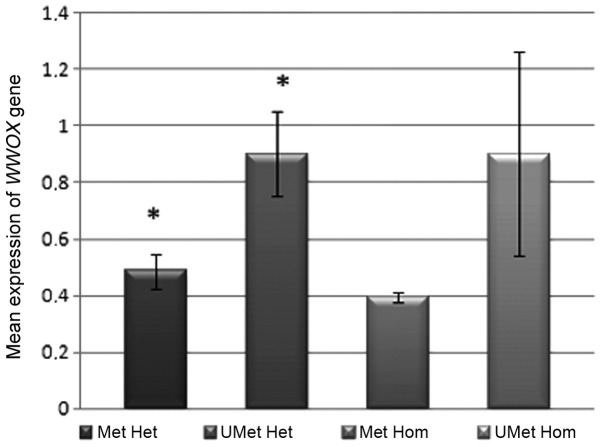
Mean expression levels of the WWOX gene associated with loss of heterozygosity in D16S3096 (marker located in intron 8 of the WWOX gene) and the methylation status of the promoter region between −508 and −174 bp (Aspin-Welsch test). *P<0.05 Met Het vs. UMet Het. Met, methylated; UMet, unmethylated; Het, heterozygous; Hom, homozygous.